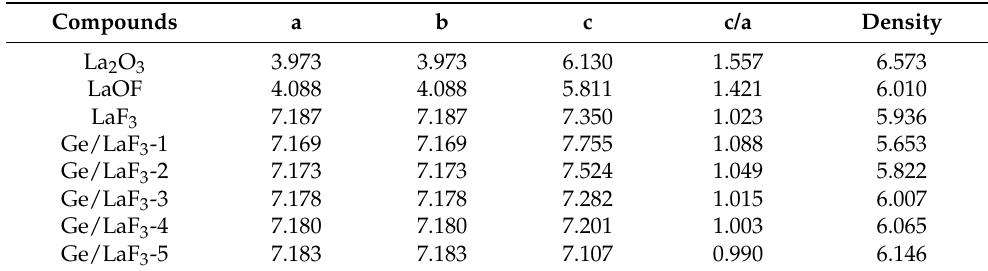
Table 1. The lattice parameters of LaF 3 thin film